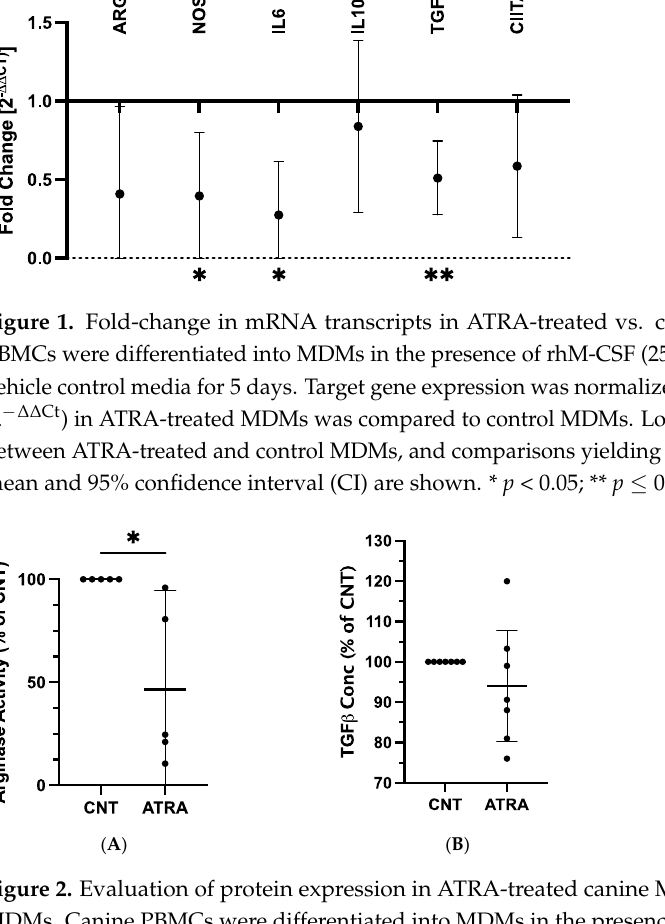
( B ) Figure 3. Phenotypic effects of ATRA on differentiating canine MDMs. Canine PBMCs were differ- entiated into MDMs in the presence of rhM-CSF (25 ng/mL), and ATRA (2 µM) or vehicle control media for 5 days. MDMs were analyzed after first gating on the myeloid cell cloud, single cells, and CD5 − cells (Supplementary Figure S1A). ( A ) Representative histograms illustrating MHCII, CD11b, CD14, and CD80 expression in control (red) and ATRA-treated (blue) MDMs. Negative expression controls (orange) consisted of FMOs for CD11b and CD80, and CD5+ INCs for MHCII and CD14. ( B ) Summary of MCHII, CD11b, CD14, and CD80 MFI in ATRA-treated MDMs, relative to control MDMs. Mean and standard deviation are shown, and individual data points are plotted. n = 3. MHCII CD11b CD14 CD80-100 -50 0